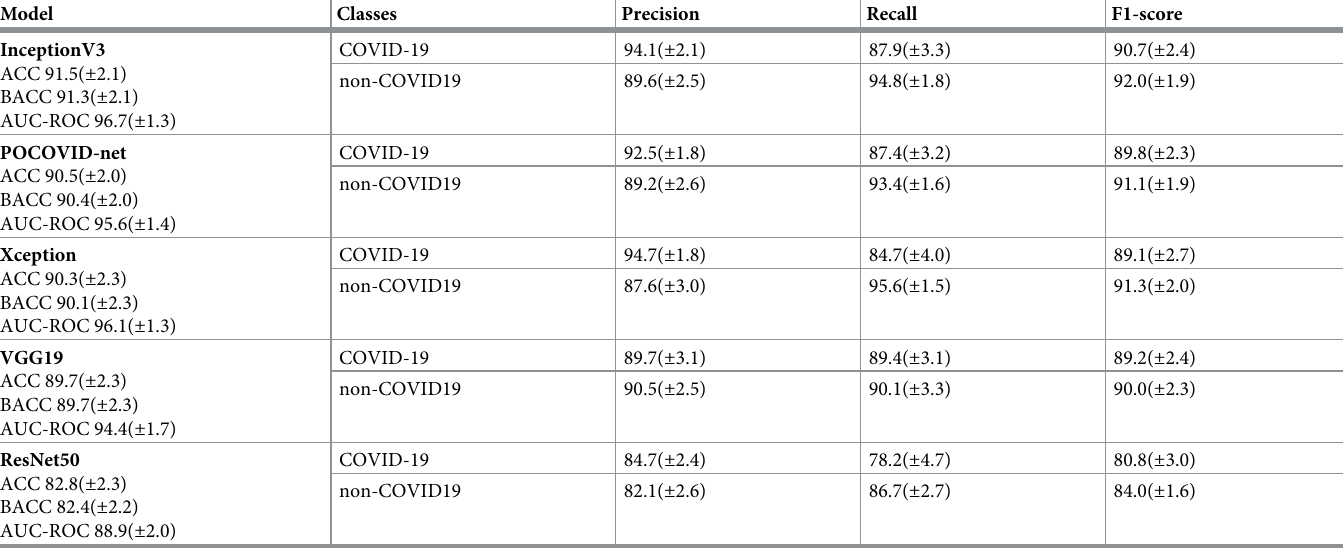
Table 4. Overall COVID-19 vs non-COVID-19 performance results (95%